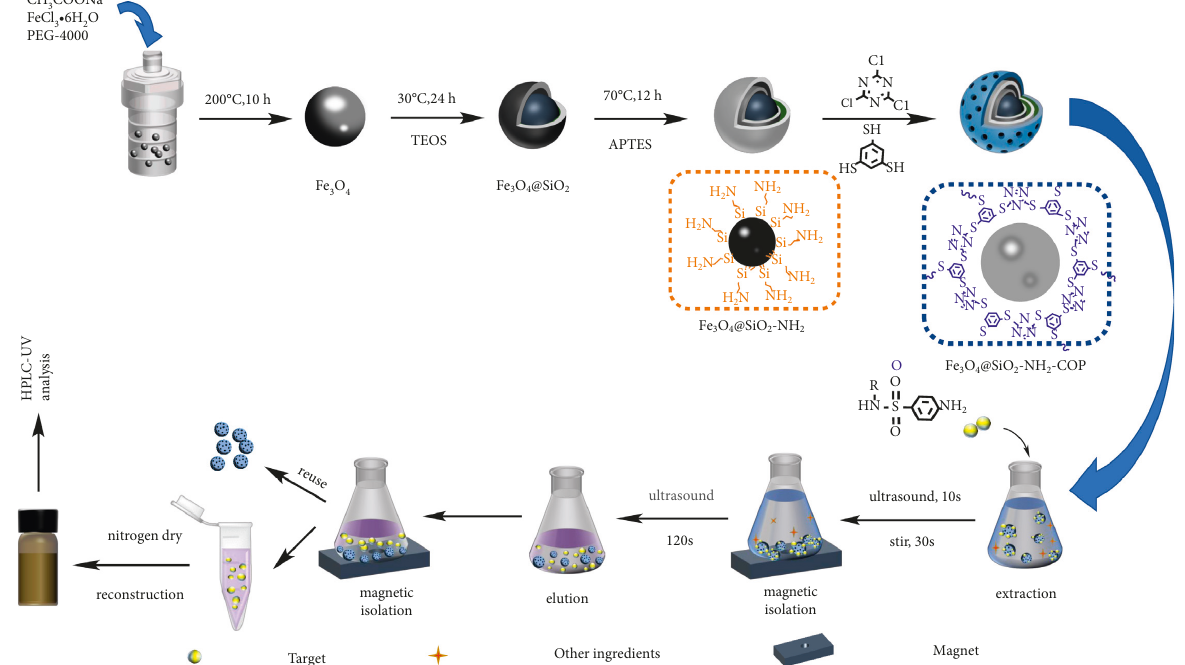
Figure 3: The synthetic route for Fe